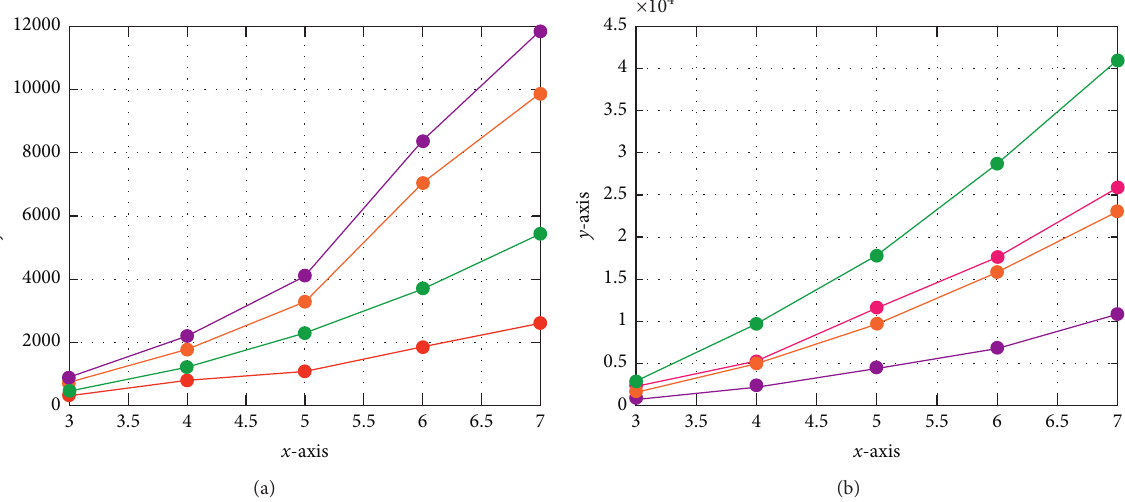
( P P ) , M ( P P ) , M ( P P ) , and M n S 1 ⊠ m n Q 1 ⊠ m n R 1 ⊠ m 1 1 1